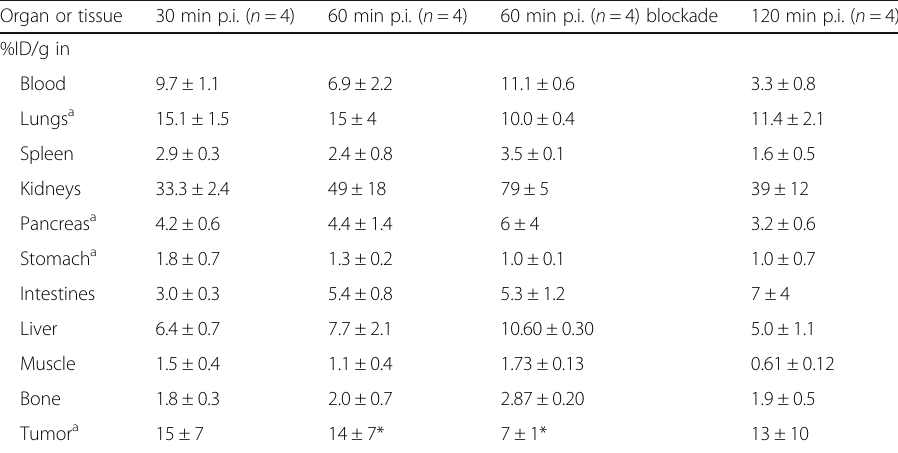
Table 1 Biodistribution data of [ 18 F] 2 in nude mice bearing CHL-GLP-1 receptor positive tumor xenografts